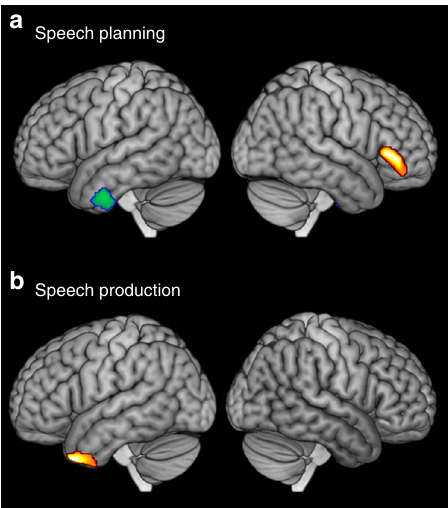
Fig. 5 Activation during speech planning and production correlated with individual differences in coherence. Red-orange shows regions with greater activation in highly coherent participants and blue-green shows regions with greater activation in less coherent participants. a Speech